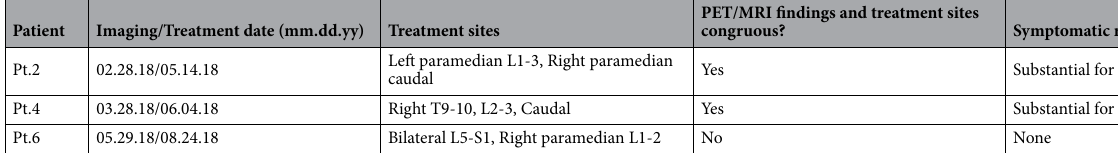
Table 3. Blood patch treatment information and the treatment